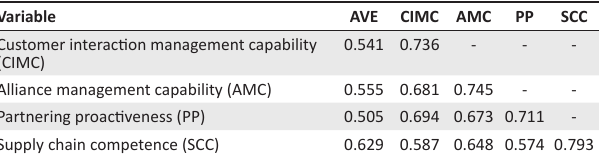
TABLE 3: Discriminant validity